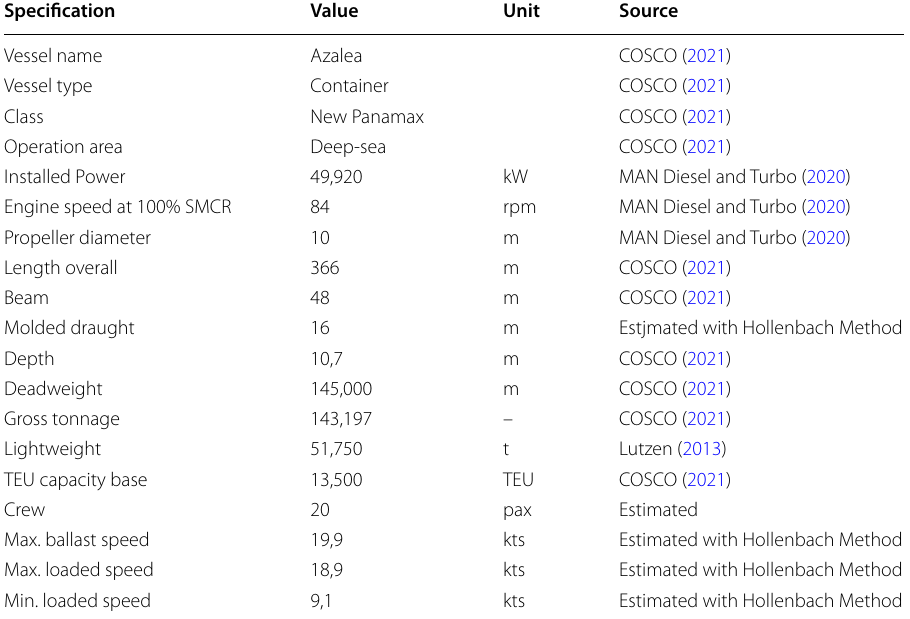
Table 7 Case study vessel